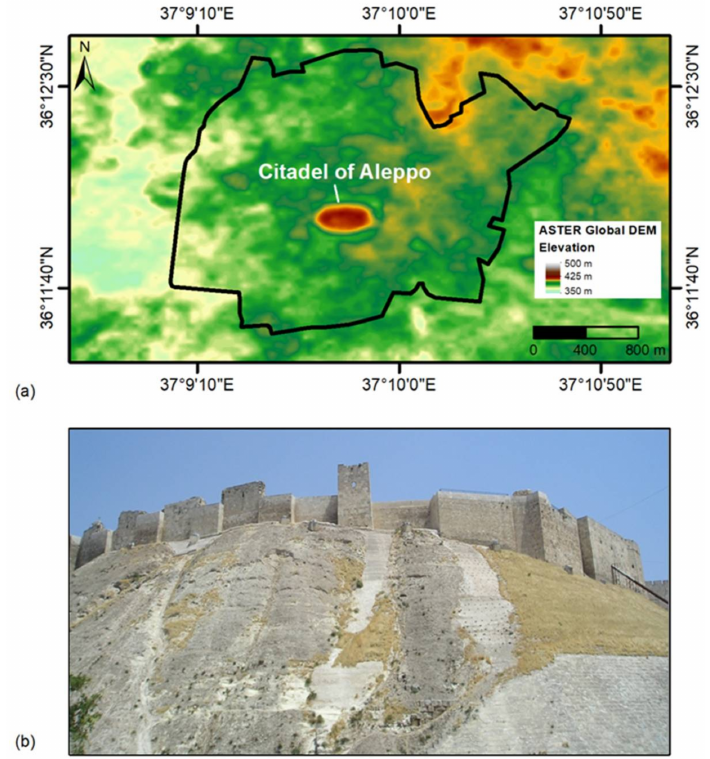
Figure 2. ( a ) Boundaries of the designated UNESCO World Heritage Site of the Ancient City of Aleppo displayed onto a 30-m resolution ASTER Global Digital Elevation Model (GDEM), with an indication of the elliptical tell of the Citadel. ( b ) View of the Citadel walls as of 1 August 2005 (photo source: Wikimedia Commons). ASTER GDEM is a product of METI and